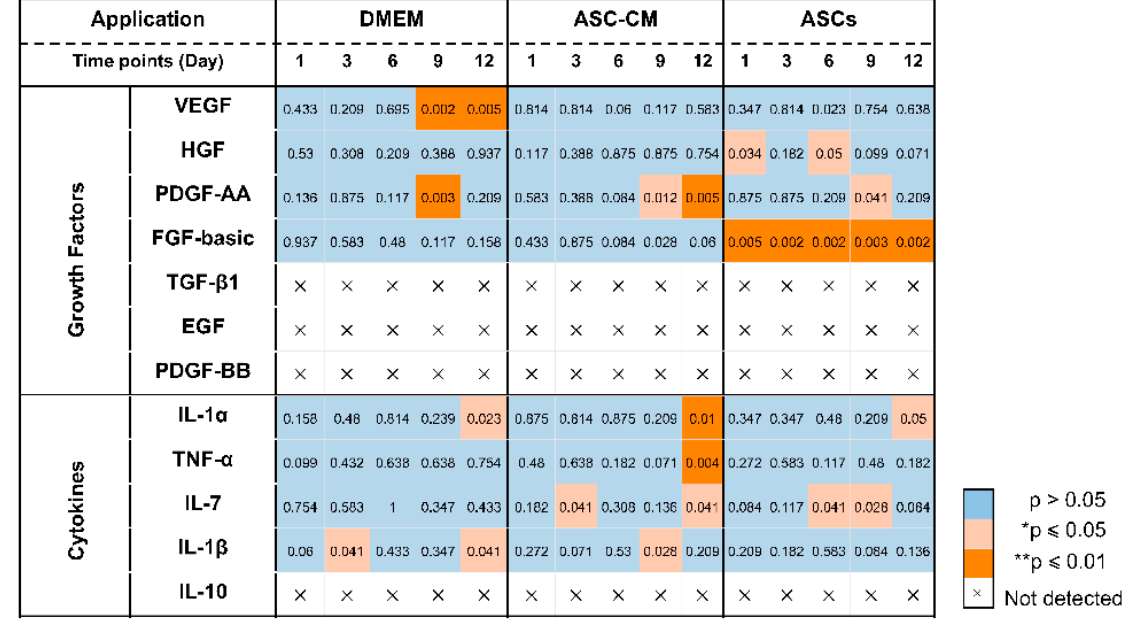
Figure 11. Visualization of statistically significant differences between treated samples and controls in wound culture media. 4.4. Effects on Inflammatory Mediators Wound healing is a highly orchestrated process that is coordinated not only by vari- ous growth factors but also by immunoregulatory cytokines. Mesenchymal stem cells